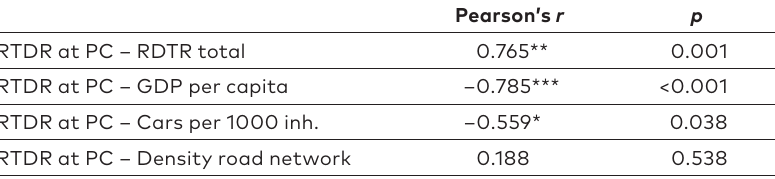
Table 3. Correlation between road traffic death rate